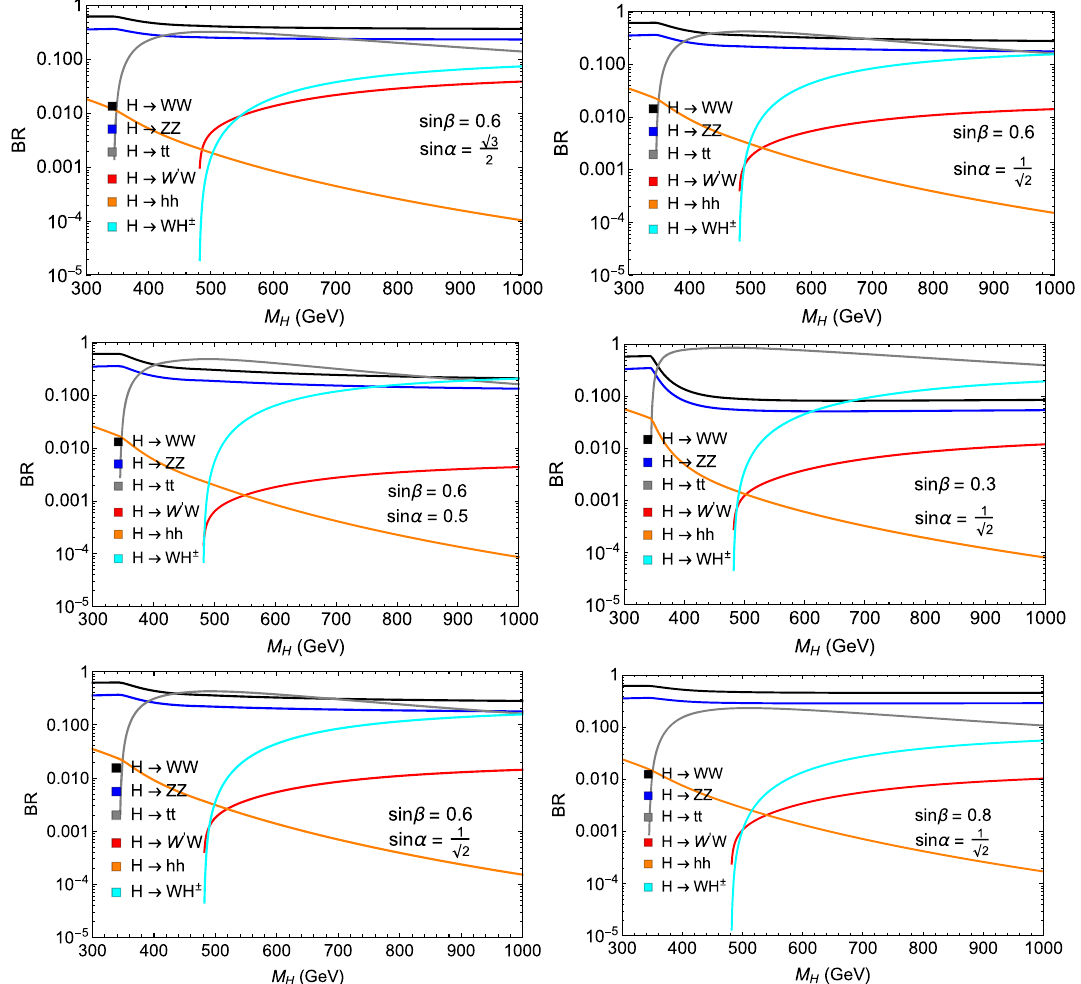
Fig. 11 The decay branching ratio of the heavy higgs H into different final states for different choices of sin α and sin